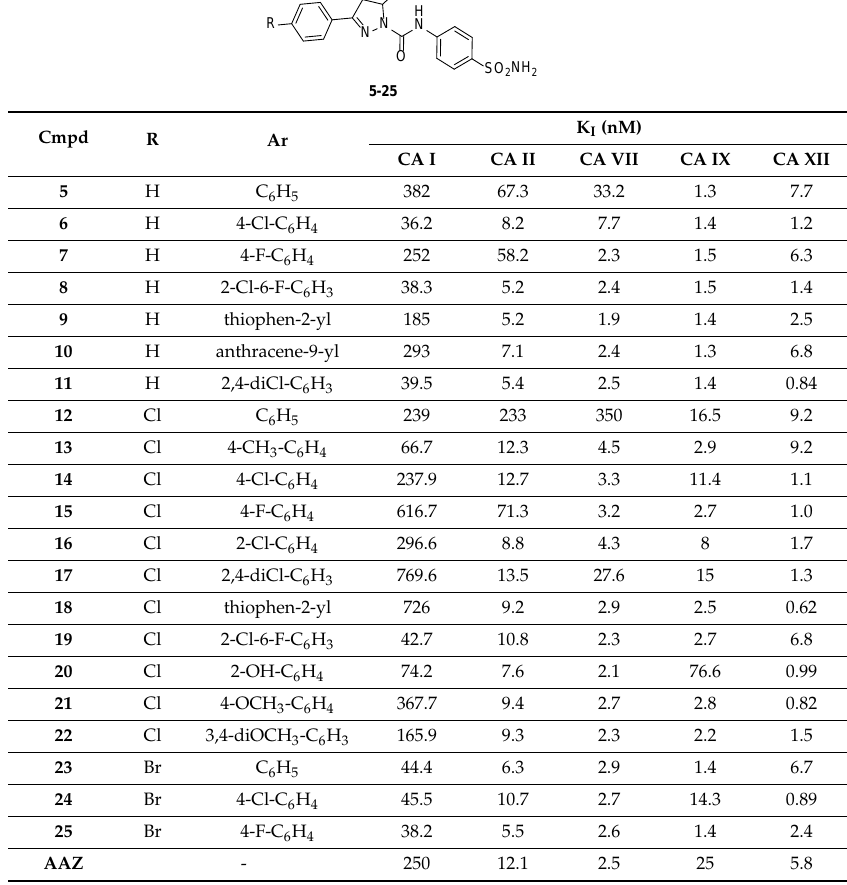
Table 1. Inhibition data of human carbonic anhydrase (CA) isoforms I, II, VII, IX, and XII with sulfonamide derivatives 5– 25 reported here and the standard sulfonamide inhibitor acetazolamide (AAZ) by a stopped-flow CO 2 hydrase assay.